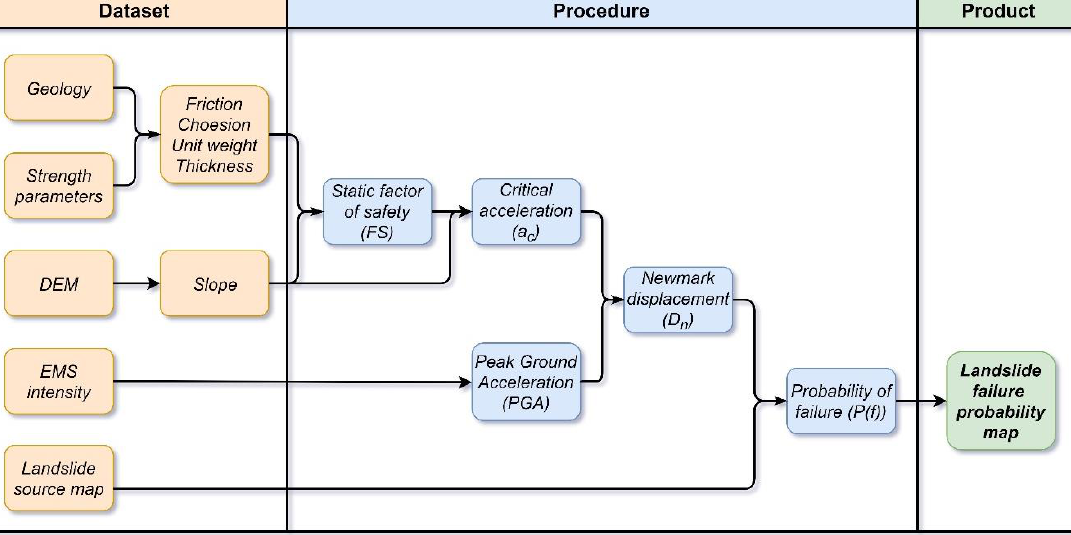
Figure 3. Flowchart showing the required steps to produce the landslide failure probability map.